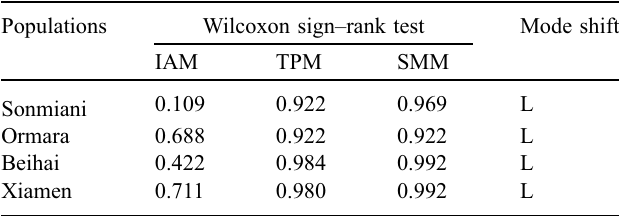
Table 6. Results of Wilcoxon's heterozygosity excess test and Mode shift indicator for a genetic bottleneck in the four populations of P. chinensis.